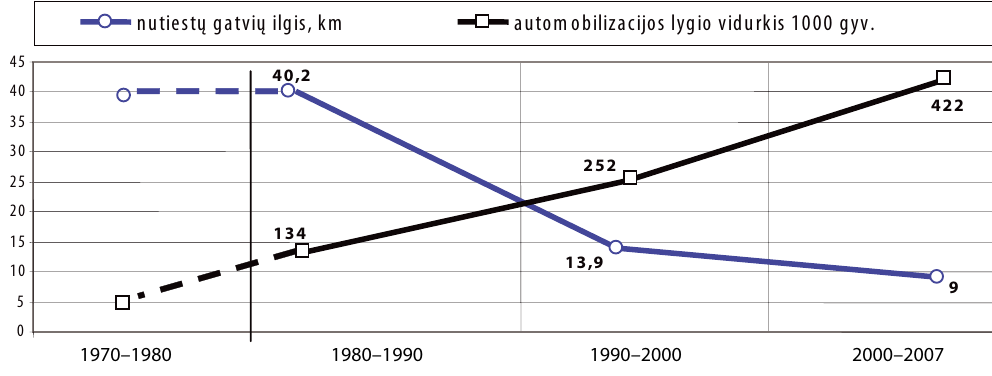
Fig. 4. Change dynamic of street building and motorization level in Vilnius